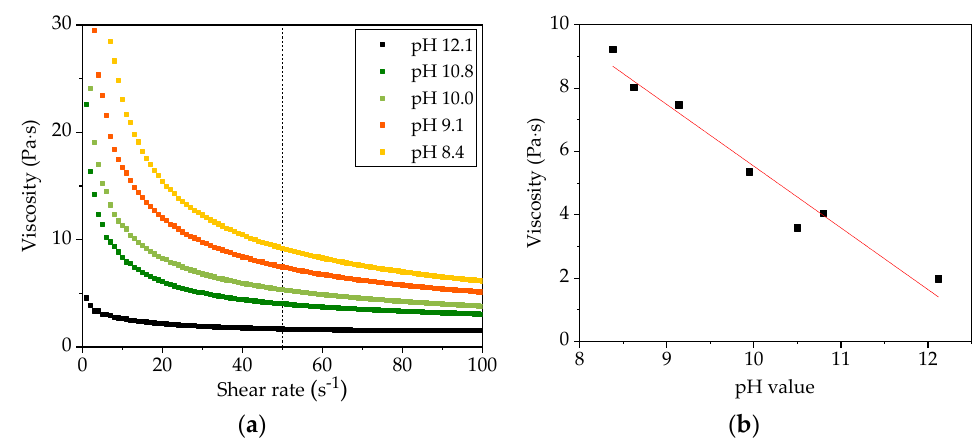
Figure 2. The viscosity of slurries as a function of ( a ) shear rate and ( b ) pH value. Slurries with different pH values were tape cast on 20 µm Al-foil and dried in ambient air. The details of the electrodes are summarized in Table 1. Thick-film electrodes with mass loading from 37 to 46 mg/cm 2 were manufactured, while thin-film electrodes with about 11 mg/cm 2 (1/4 in comparison to thick-film electrodes) were used to represent electrodes with a state-of-the-art film thickness. It was found that without acid addition, the cathodes have a high porosity of about 60%. For example, the cathode with a slurry pH value of 12.1 shows a 50 µm thicker layer in comparison to the cathode with a slurry pH value of 10.8, while the mass loading is reduced by 6 mg/cm 2 . Table 1. Electrode data after calendering.